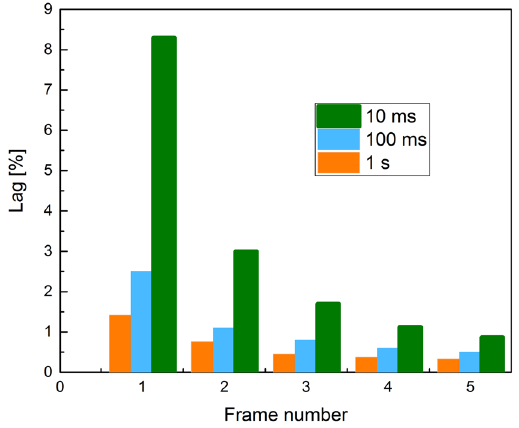
Figure 4. The lag (presented as a percentage of I peak ) is shown as the function of a frame number. The frame read-out time is the same as exposure duration.